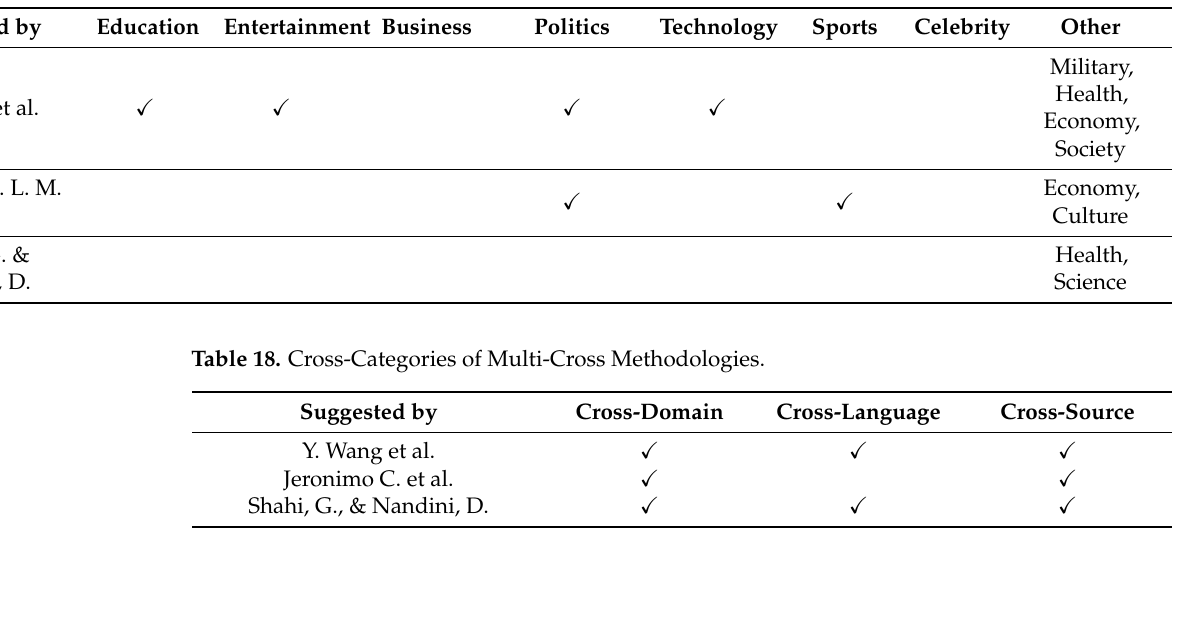
Table 17. Domains Covered by Multi-Cross Methodologies.